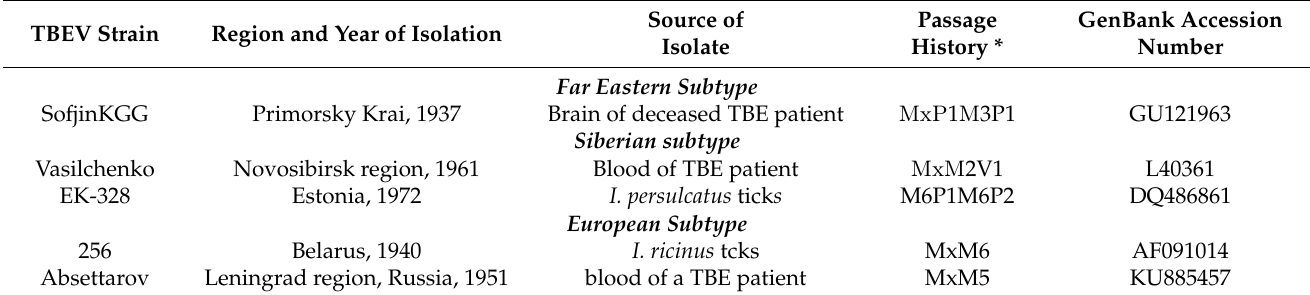
Table 1. TBEV strains used for virus challenge and in Plaque Reduction Neutralization Test (PRNT 50